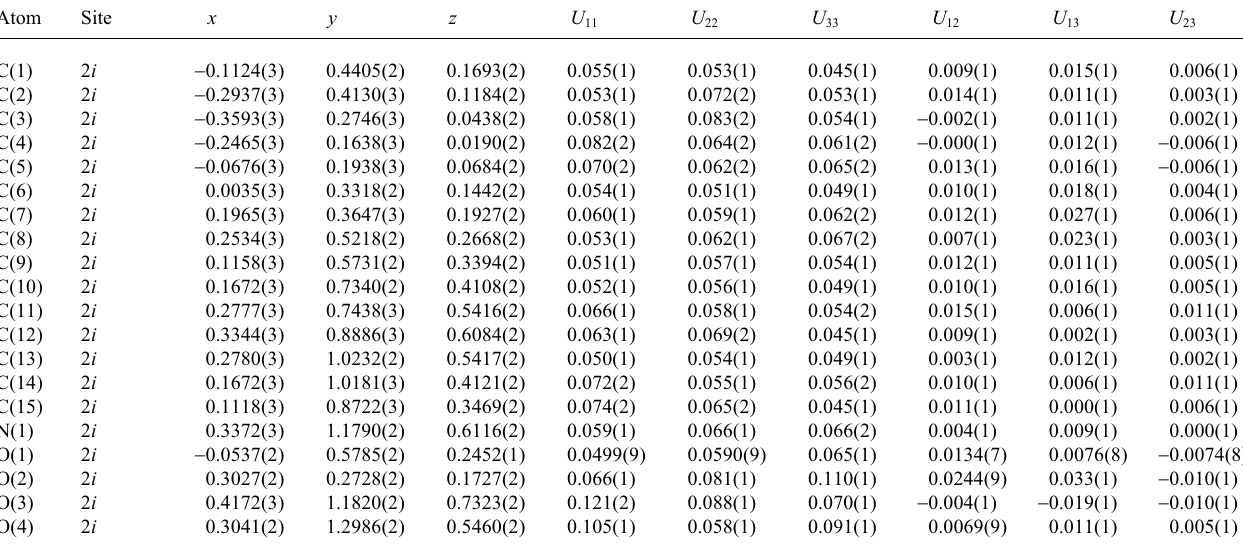
Table 3. Atomic coordinates and displacement parameters (in Å 2 )